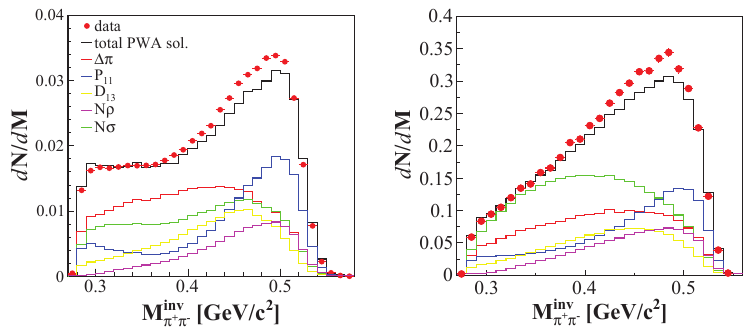
Figure 2. The acceptance corrected distributions of π + π − invariant mass at 656 MeV / c pion beam momentum (red circles) in comparison to the PWA solutions within the HADES acceptance (left panel) and after acceptance correction, deduced from the PWA solution (right panel). The lines represent PWA contributions specified in the legend. P 11 and D 13 refere to 1